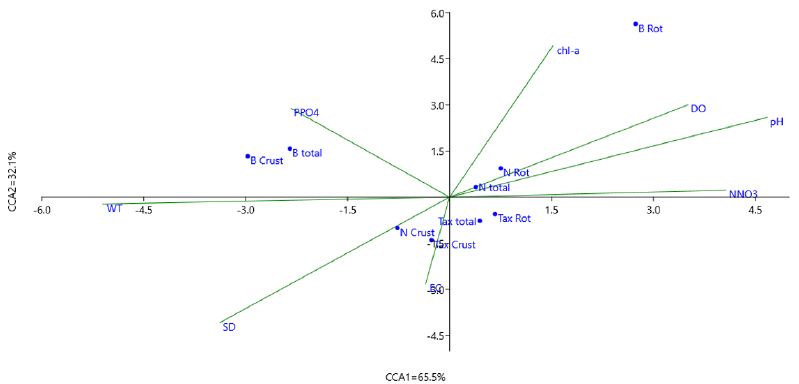
Figure 3. Results of canonical correspondence analysis (CCA) performed on zooplankton and environmental data during vegetation season at the Bydgoszcz Canal using forward selection of variables ( p < 0.01). Triplot of significant environmental variables (water temperature: WT, Secchi disk visibility: SD, conductivity: EC, oxygen concentration: DO, pH, chlorophyll: chl- a , nitrate: NNO 3 – , phosphate: PPO 42 – ), number of zooplankton species (Tax total, Tax Rot, Tax Crust), zooplankton density (N total, N Rot, N Crust) and zooplankton biomass (B total, B Rot, B Crust).